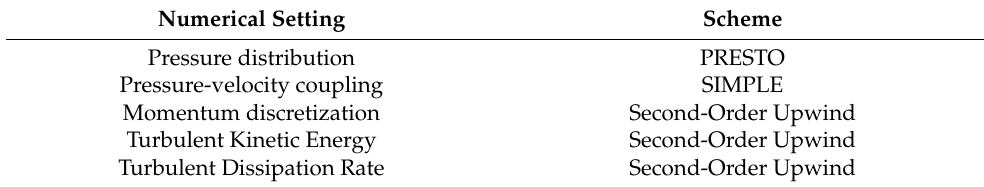
Table 4. Numerical scheme for